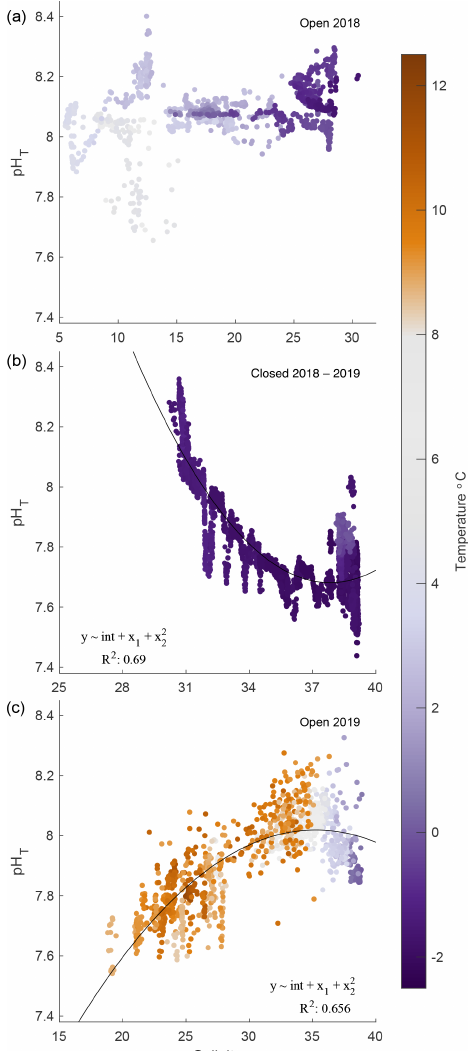
Figure 6. pH T –salinity correlations for 2018 open (a) , 2018/19 closed (b) , and 2019 open (c) phases. Quadratic fits are applied to 2019 iced and open phases only. Temperature is represented in color for all